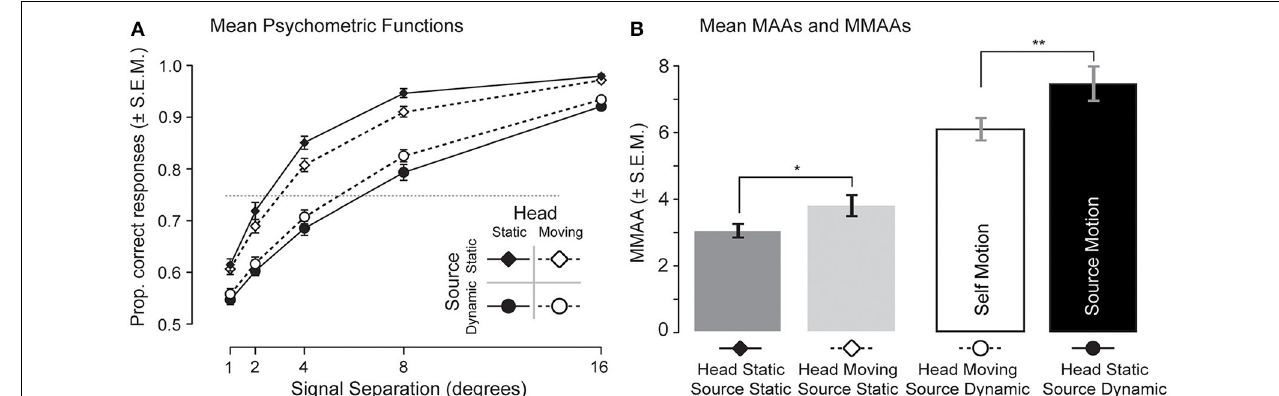
FIGURE 3 | Psychometric functions and measurements of the minimum audible angle. (A) The mean psychometric functions for all listeners are plotted for all four conditions including: (1) head static/source static (solid diamonds), (2) head moving/source static (open diamonds), (3) head static/source dynamic (solid circles), and (4) head moving/source dynamic (open circles). Error bars show ± 1 standard